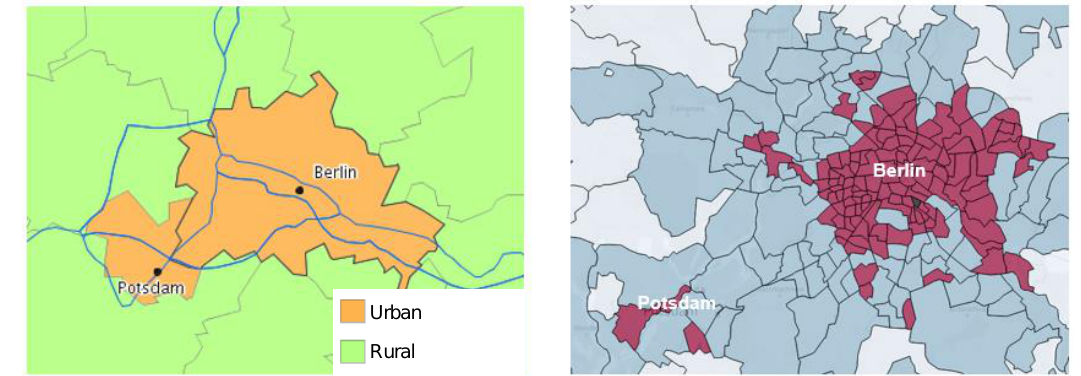
Figure 5. Visual comparison of Berlin by Urbanity Index (UI) and classification of Federal Institute for Research on Building, Urban Affairs, and Spatial Development (BBSR)